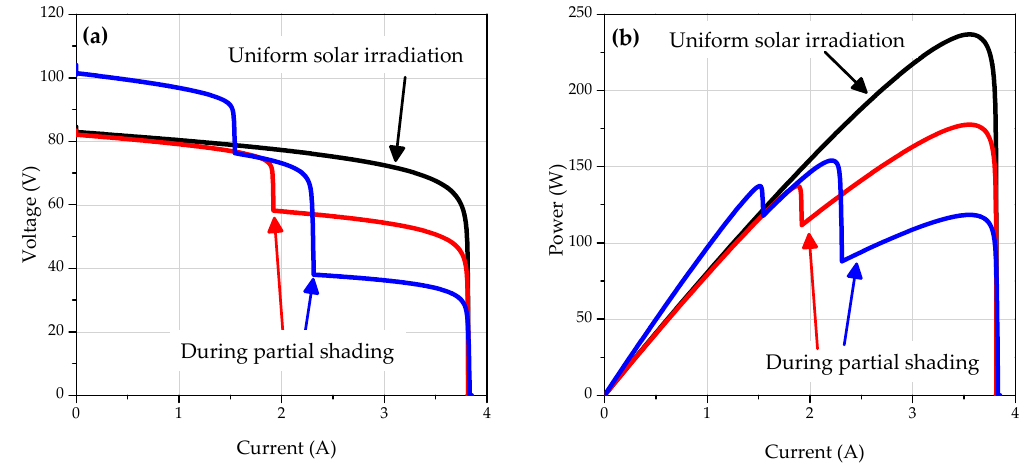
Figure 1. The voltage–current ( V – I ) and power–current ( P – I ) curves for under uniform irradiation and partial shading